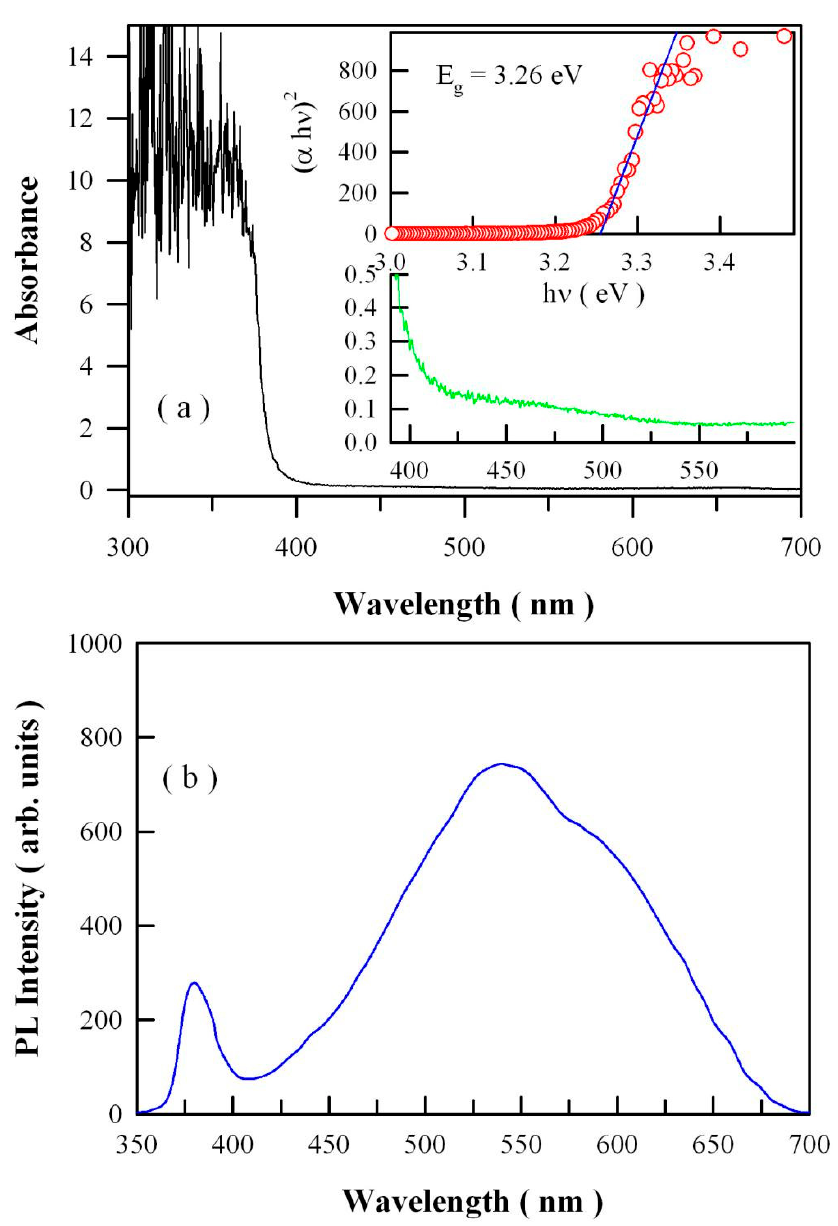
Figure 3. Ultraviolet-visible (UV-Vis) absorption spectrum ( a ) and PL spectrum ( b ) of undoped ZnO nanocrystals. Inset of ( a ): Tauc plot and sectional absorbance of the undoped ZnO nanocrystals.